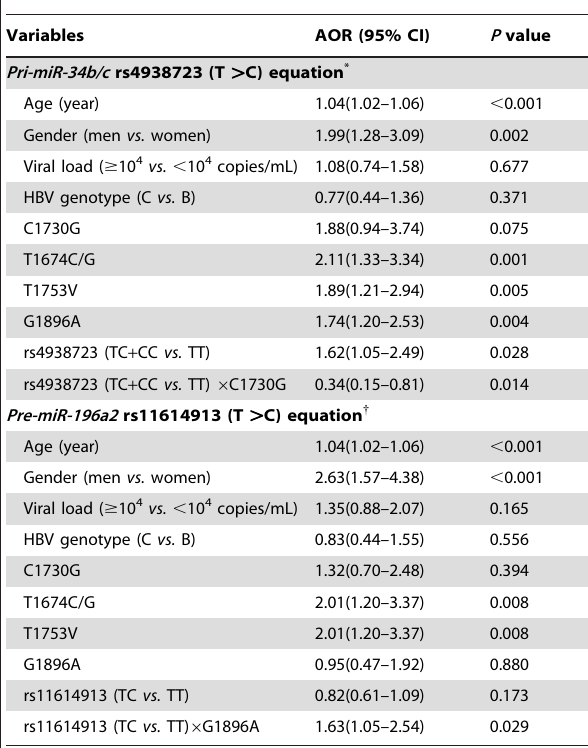
Table 4. Contributions of pri-miR-34b/c and pre-miR-196a2 polymorphisms and their interactions with the HBV mutations in the EnhII/BCP/PC region to the risk of HCC in multivariate regression